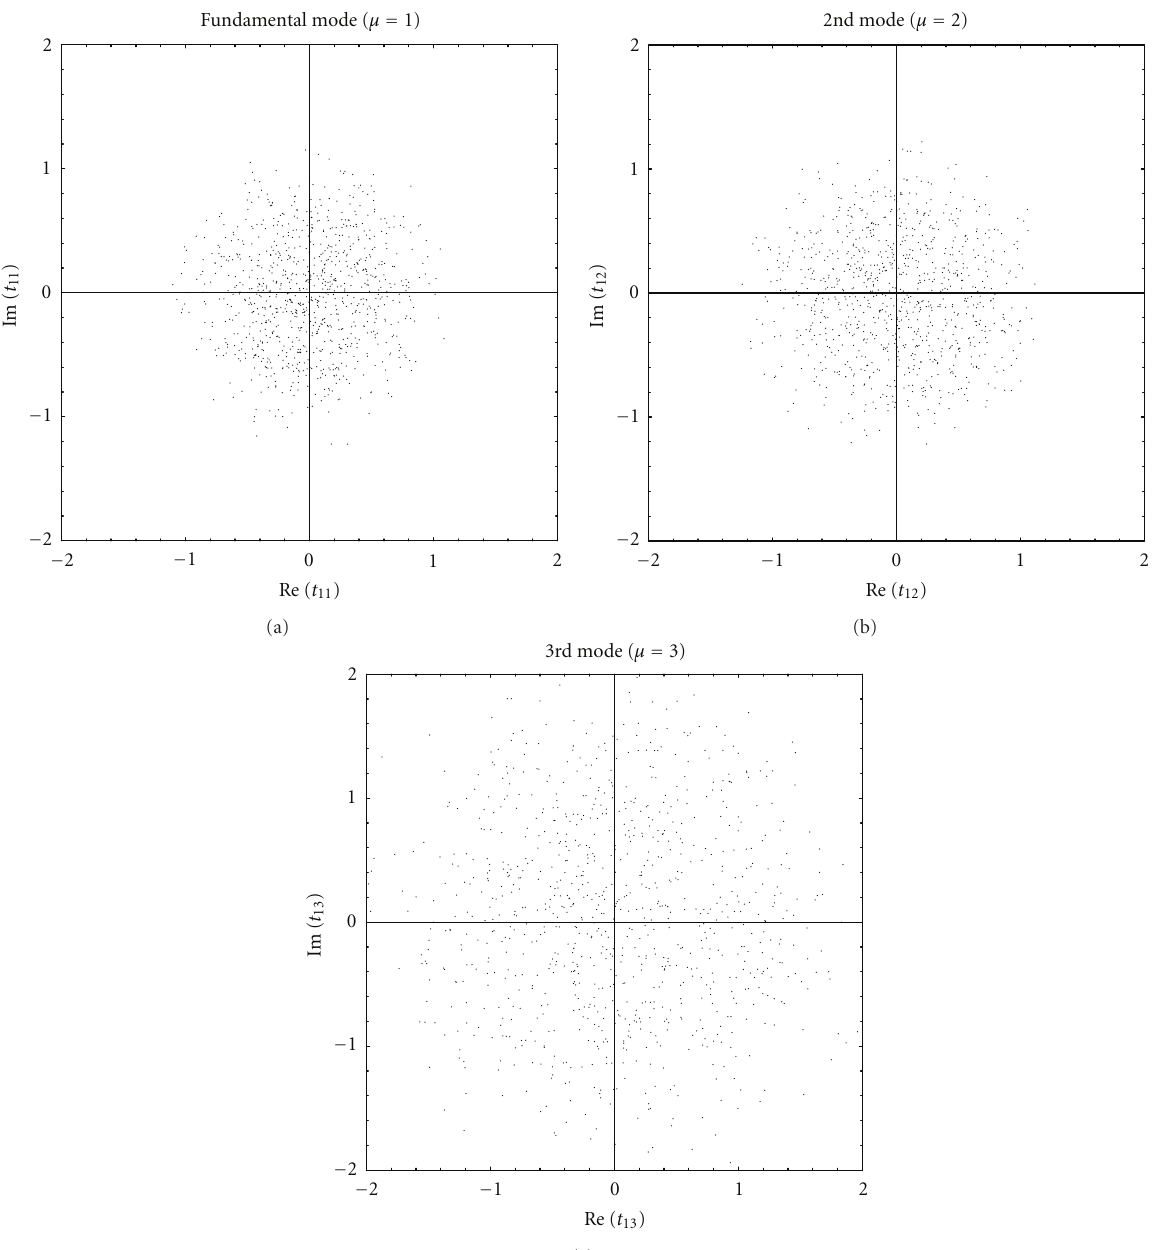
√ 32 π and (cid:4) B =